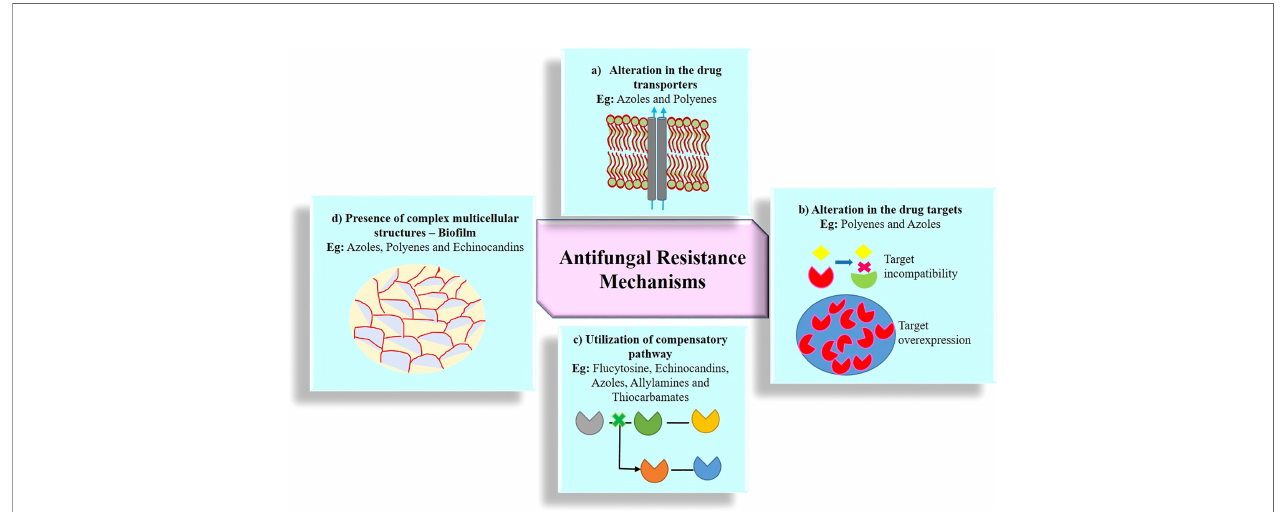
FIGURE 3 | Emergence of antifungal resistance through various mechanisms. (A) Alteration in the drug transporters reduce the accumulation of drug molecules in the cell and expel the drugs out of the cell via ef fl ux protein transporter; two kind of major ef fl ux pump transporters are ABC (ATP-binding cassette) protein transporters and MFS (major facilitator superfamily) protein transporters; (B) alteration in the drug targets substantially reduces the af fi nity of the drug for its targets by structural modi fi cation, mutation, upregulation, downregulation, and overexpression of drug targets; (C) utilization of compensatory pathways, ergosterol biosynthesis pathway alteration, and plasma membrane composition variation; (D) presence of complex multicellular structures, formation of bio fi lm, and polymicrobial bio fi lms (bacterial species often associated with one or more fungal